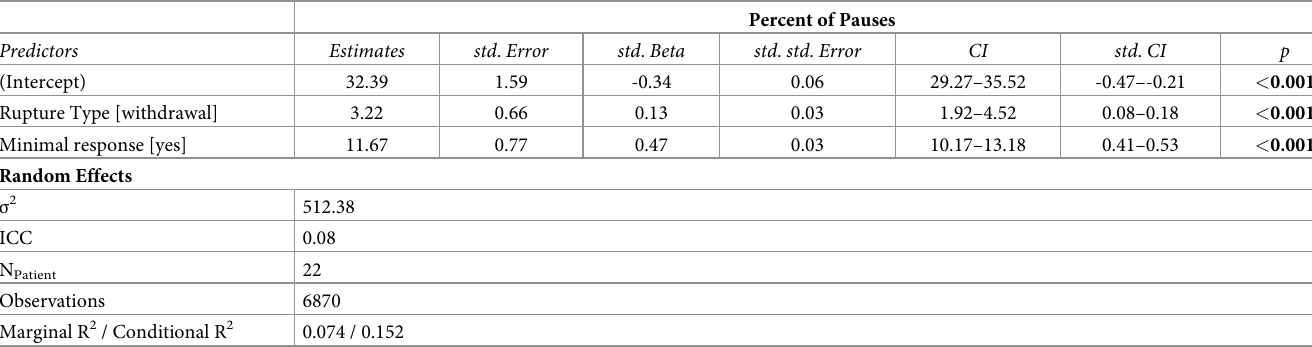
Table 2. Percent of pauses predicted by rupture type and minimal response (Model